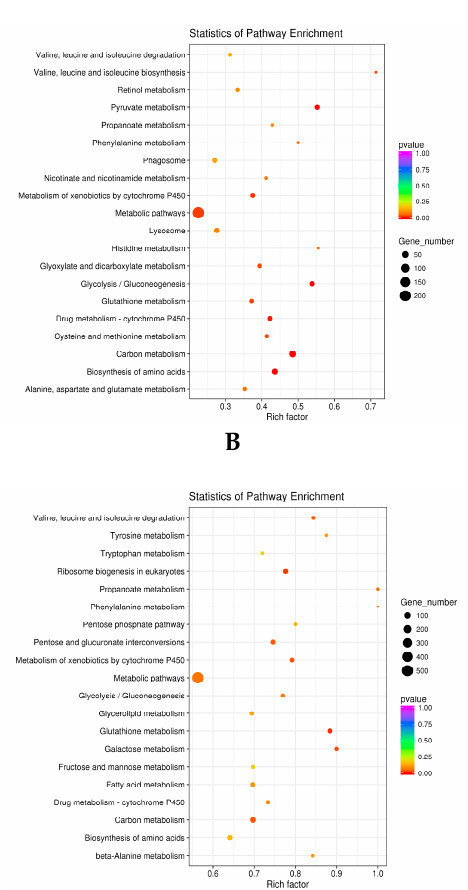
Figure 4. Functional annotation of differentially expressed genes using the KEGG database. ( A ) C2-0.1 mg/mL vs. CK; ( B ) C2-0.5 mg/mL vs. CK.